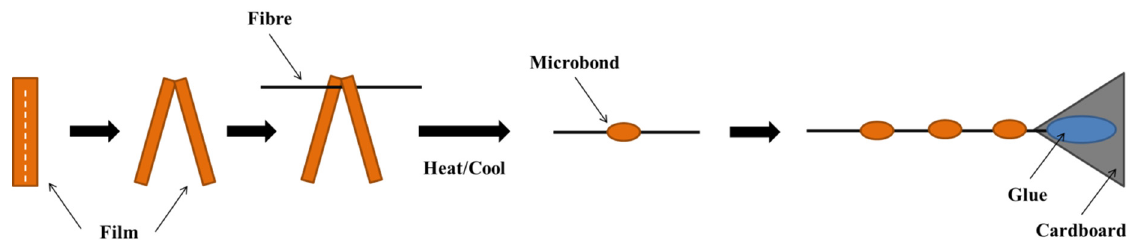
Figure 1. Procedure to form thermoplastic resin droplets on fibers.